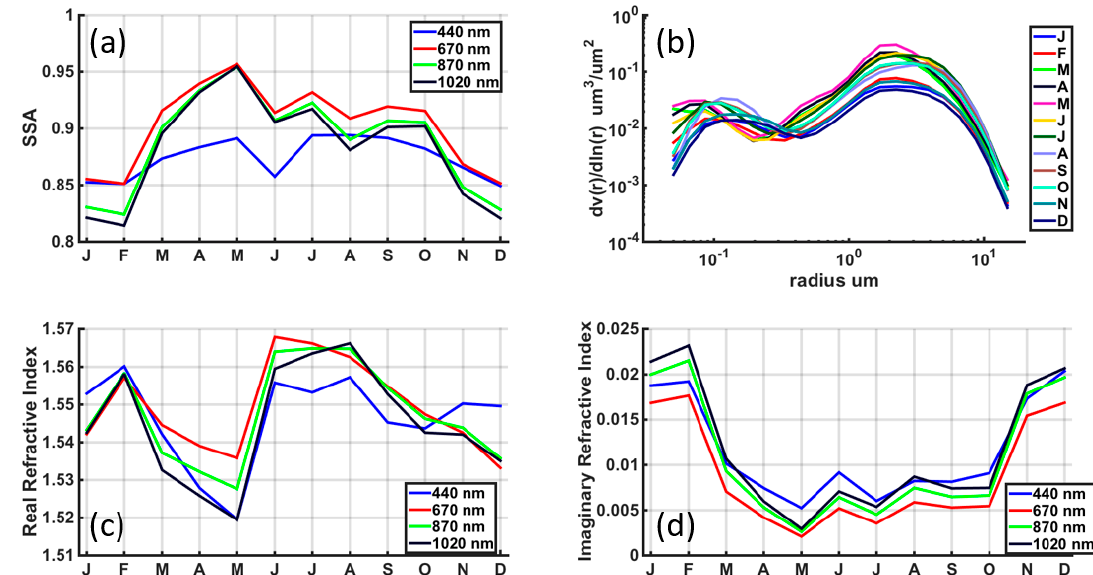
Figure 4. Monthly variability of AOD 500 and AE coefficient (blue and black solid lines, respectively), obtained by AERONET for the time period 2008–2017. Monthly variability of AOD 550 , obtained by MODIS (green solid line) for the same time period, over Kuwait area. The error bars represent the corresponding standard deviation of the monthly mean values.